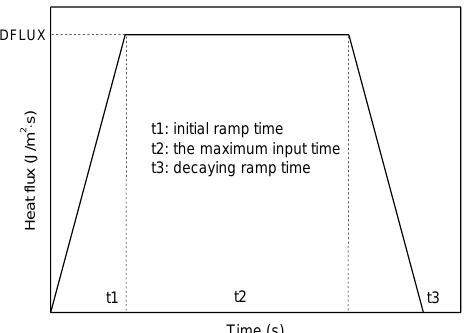
Figure 8. Ramp heat input model.